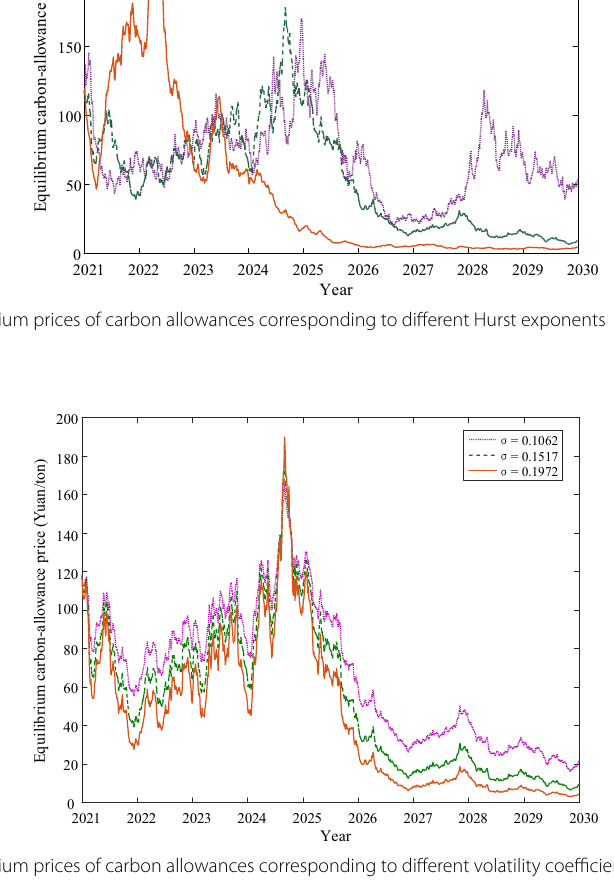
Effect of volatility coefficient for energy‑switching prices on the equilibrium price of carbon allowances Volatility was set to 0.1517 by default. For the sensitivity analysis of the equilibrium price of CAs, the values 0.1062 and 0.1972 after 30% up and down fluctuations from the default value were chosen.